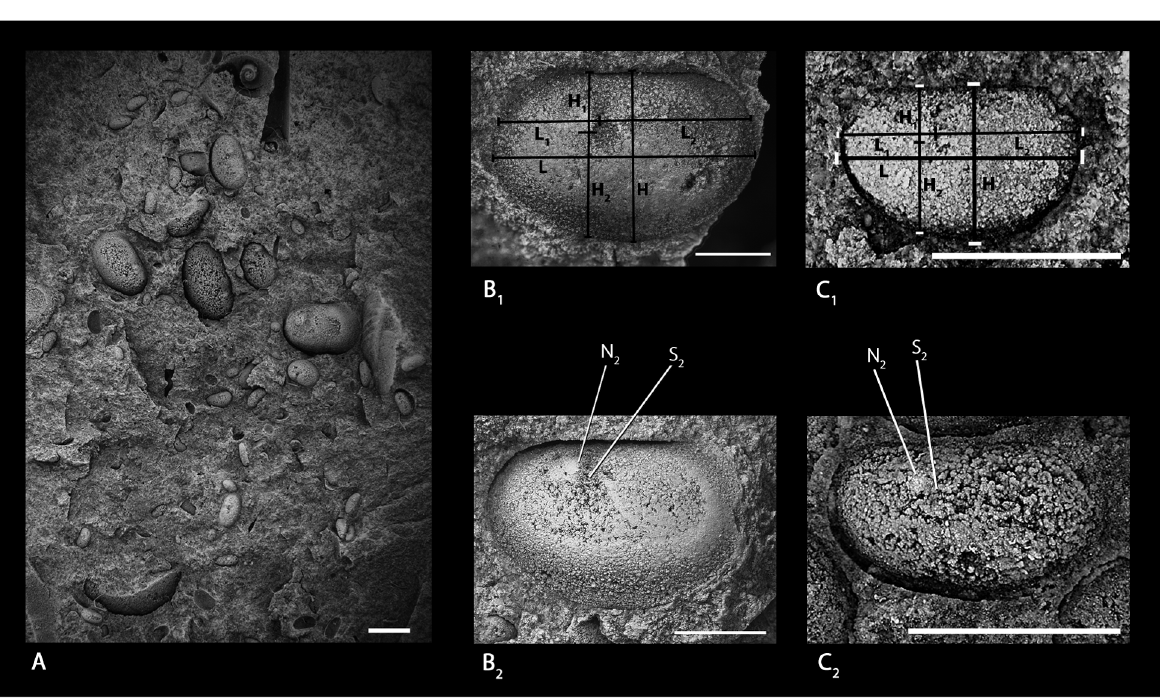
Fig. 1. A . Siliceous nodule with ostracods, NM L 36446, locality Osek. B 1 , B 2 , specimens representing the growth stage classified formerly as Conchoprimites osekensis P ř ibyl, 1979. B 1 , biometric features, NM L 35977, left valve, locality Osek; B 2 , morpho-